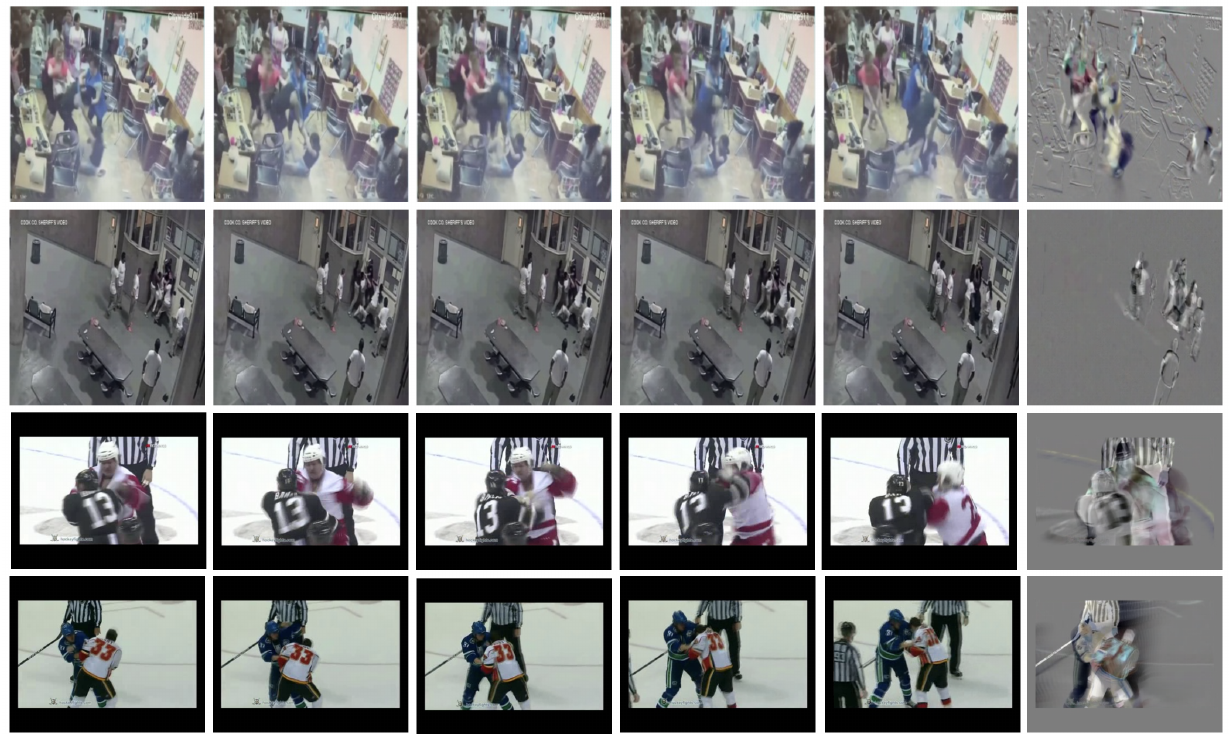
Figure 2. Examples of dynamic images representing violent actions. Each row represents a frame sequence of a video summarized by a dynamic image (last